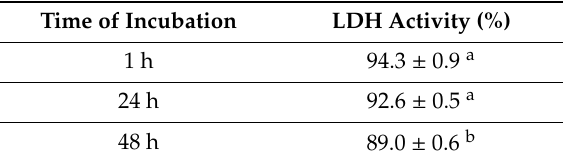
Table 3. Lactate dehydrogenase (LDH) activity measured in conditioned culture medium of equine endometrial explants after 1 h, 24 h, or 48 h incubation. Explants’ viability was calculated from the quotient of the intracellular LDH activity and the total activity (extracellular plus intracellular LDH). Results are presented as means ± SEM. Di ff erent superscript letters indicate statistical di ff erences within time of incubation.